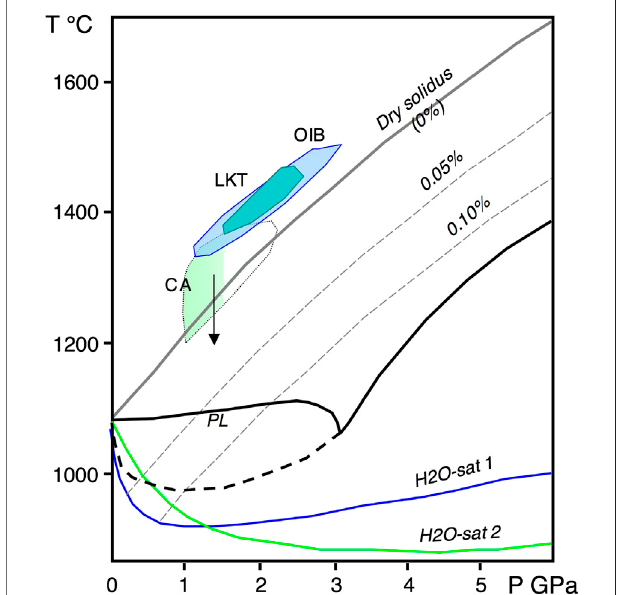
FIGURE 11 | Estimated P – T conditions for last equilibration of primitive Cascades basaltic lavas (from Figure 10 ) assuming lherzolitic mantle sources (Mg# (cid:1) 90) for all. These are compared with representative mantle solidi curves. Gray lines are calculated peridotite solidi with 0, 0.05, and 0.10 wt%H 2 O(Katzetal.,2003).EquivalentdrysolidusofHirschmann(2000) (for plot, see Supplementary Table S2 ) is slightly warmer than labeled “ Dry solidus. ” Bold black line is experimental solidus for pargasite lherzolite (PL) with ∼ 0.02% ppm H 2 O; bold dashed and solid line at p above 3 GPa represent mantle vapor-saturated solidus (Green et al., 2014). Blue and green curves (H 2 O-sat 1 and H 2 O-sat 2), solidi for water-saturated peridotite (also see Fig. 2), are considered less realistic by Green et al. (2014). Cascades LKT and OIB lavas are consistent with essentially anhydrous sources. CA type melts with temperature adjustments (arrow) for up to 3 wt% H 2 O, lie near or plot below the dry solidus — consistent with their formation from slightly hydrated sources. Alternative source models need to be evaluated further for these